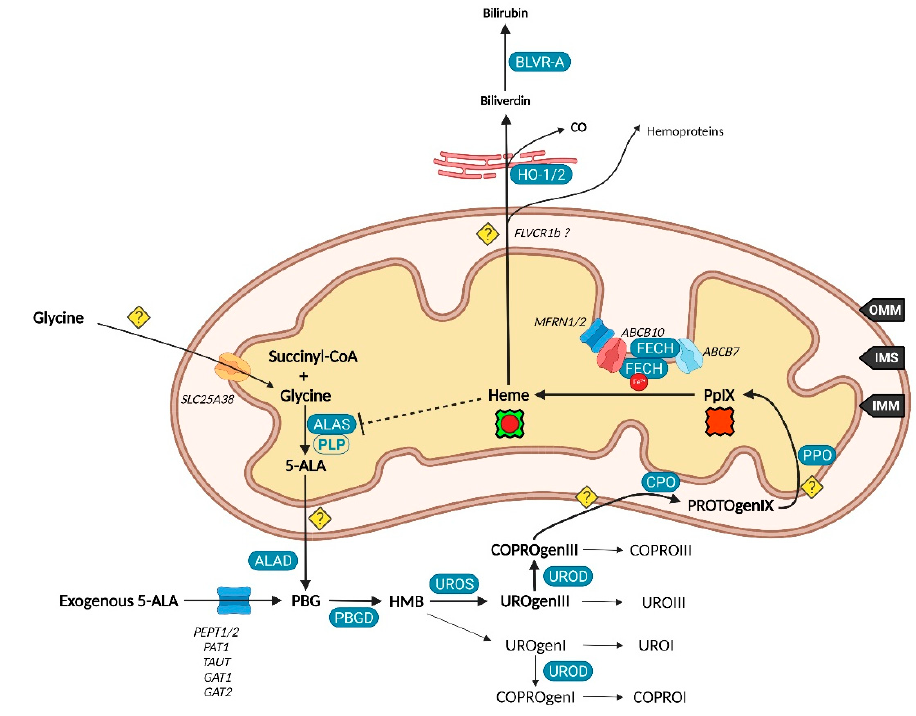
Figure 3. Ten companions, the fellowship of the